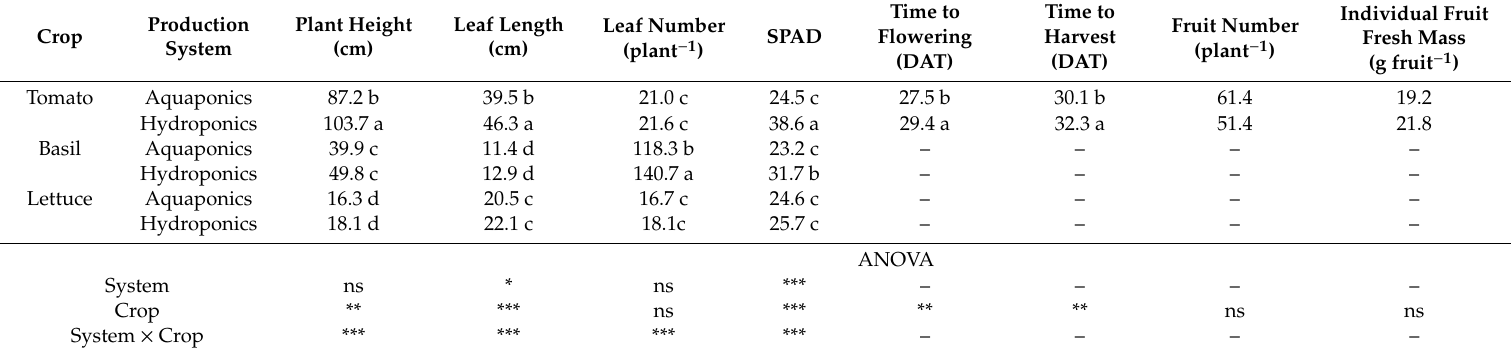
Table 4. Growth and harvest parameters of tomato, basil, and lettuce grown in aquaponic and hydroponic systems.